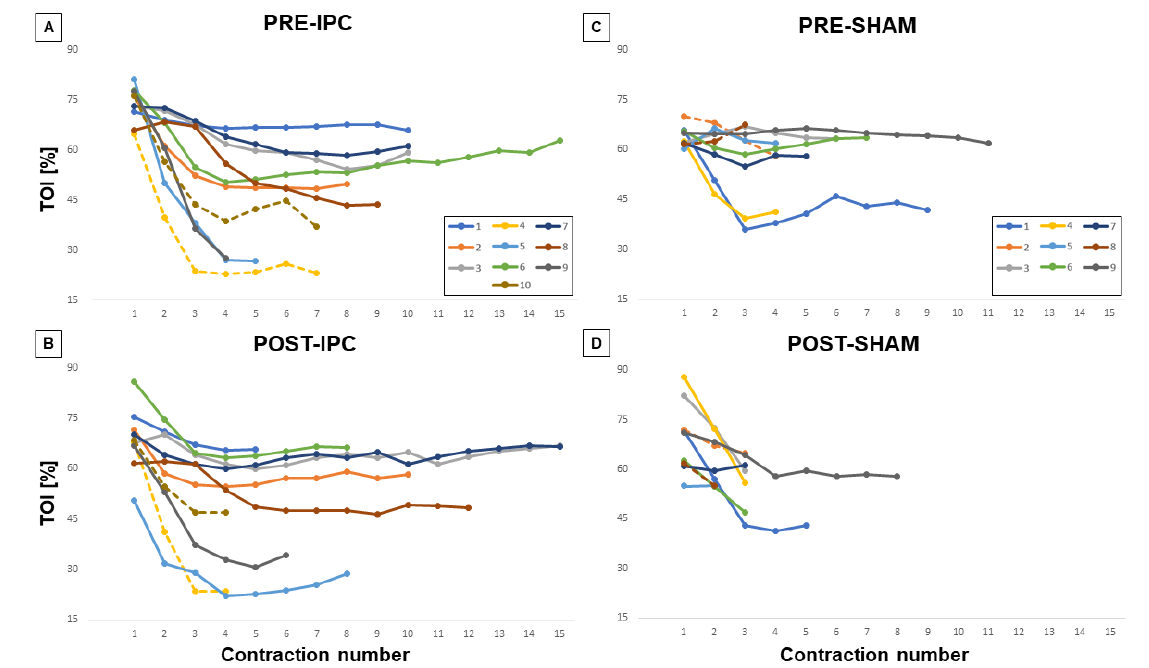
Figure 4. Individual changes in TOI during exercise. Each line corresponds to a different subject and each dot represents an individual contraction during the exercise task for the two groups IPC ( A , B ) and SHAM ( C , D ) and the pre- ( A , C ) and post-treatment conditions ( B , D ). Dashed lines refer to the individual curves of female subjects.